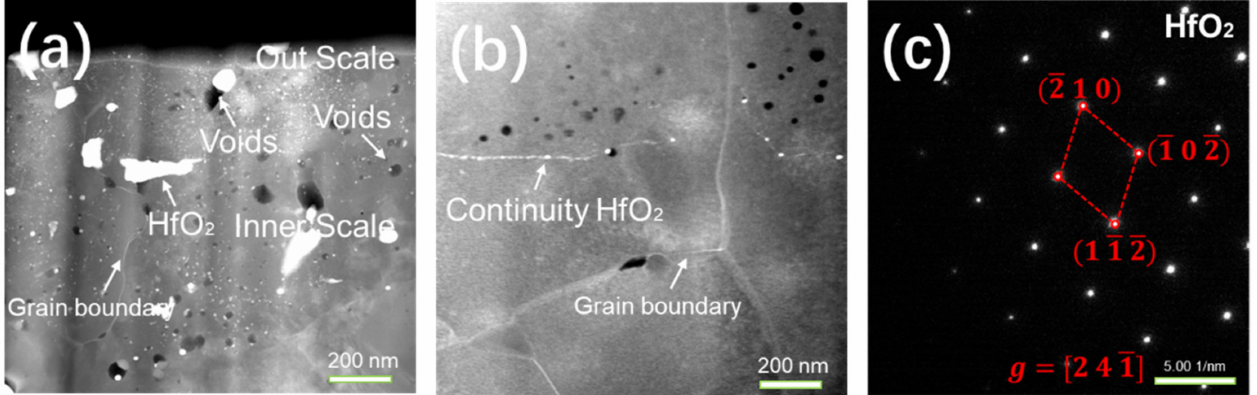
Figure 9. The STEM images of the outer part of the oxide scale formed using different atmospheres and heating methods: ( a ) in air and stepped heating conditions; ( b ) in air and constant heating conditions; ( c ) the SAED patterns of HfO 2